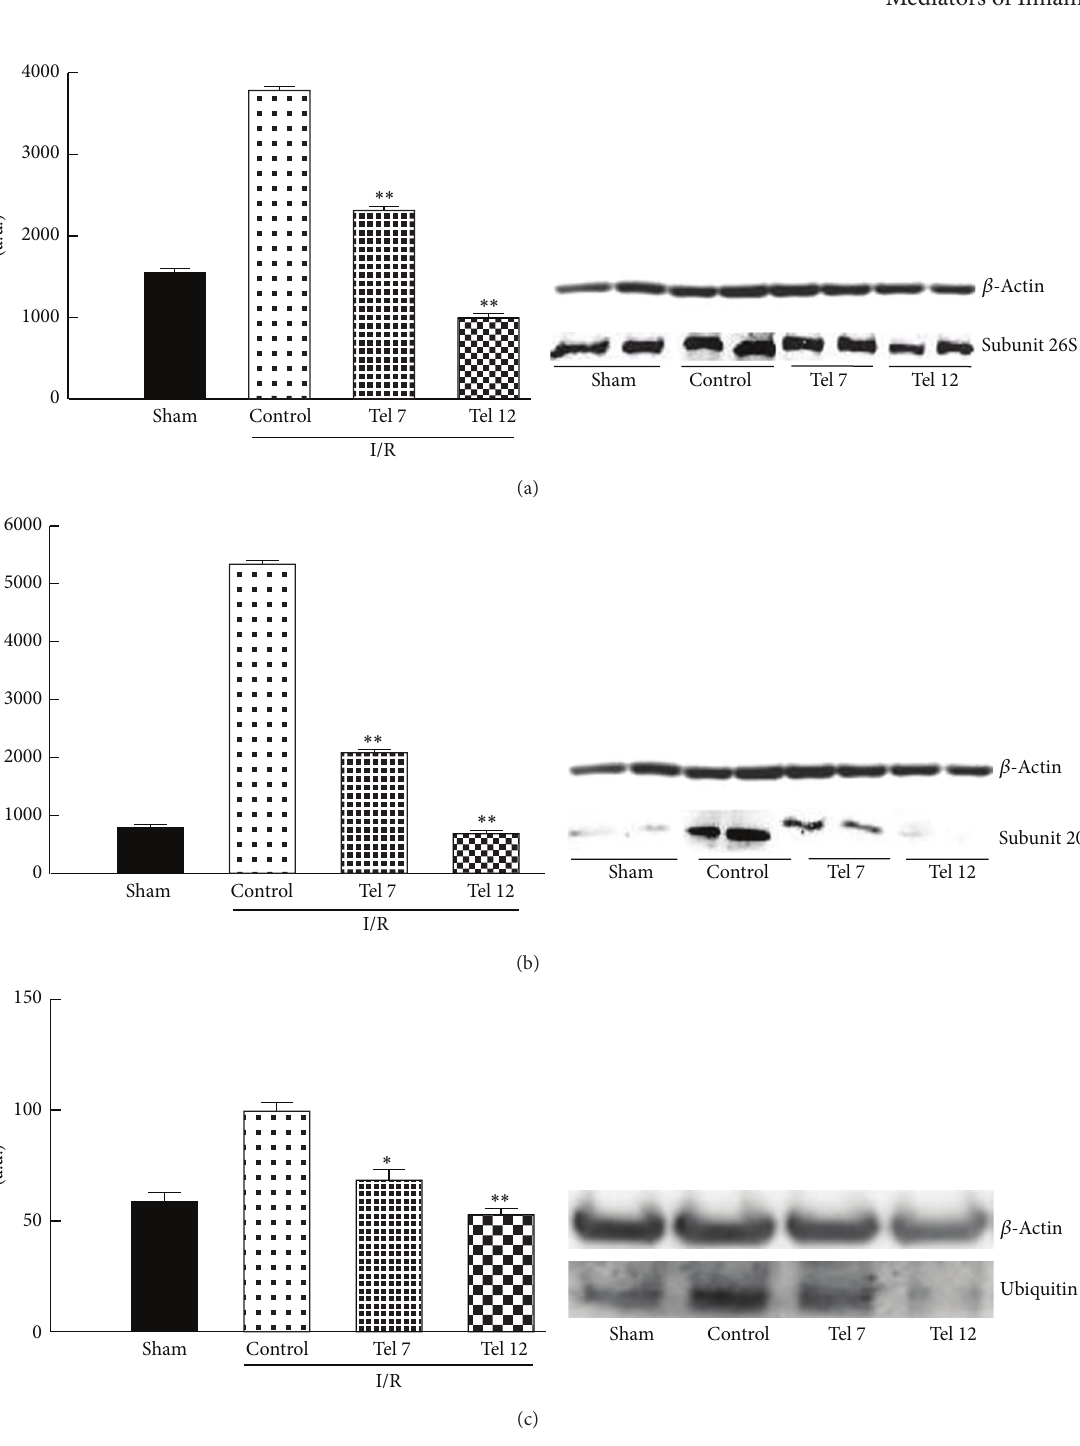
Figure 2: Effect of telmisartan on the expression of proteasome and ubiquitin. Telmisartan (tel) reduces in a dose-dependent fashion the expression of (a) 26S, (b) 20S proteasome subunits, and (c) ubiquitin in infarcted heart tissue of rats as shown by Western blot analysis. Values are reported as mean ± standard error. ∗ 𝑃 < 0.05 and ∗∗ 𝑃 < 0.01 versus control. I/R (ischemia/reperfusion); tel 7 (telmisartan 7 mg/kg); tel 12 (telmisartan